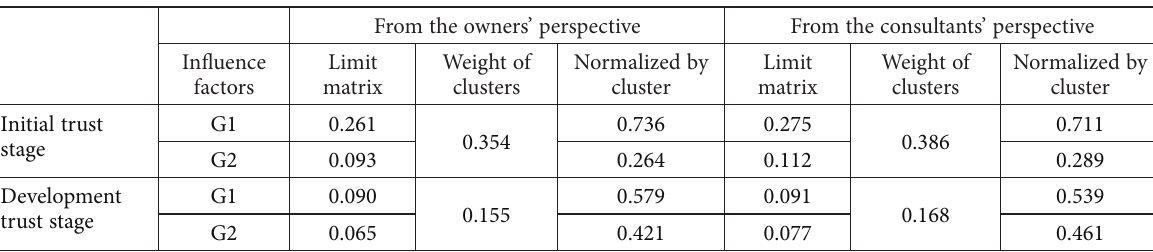
Table 6. The changes in the guanxi